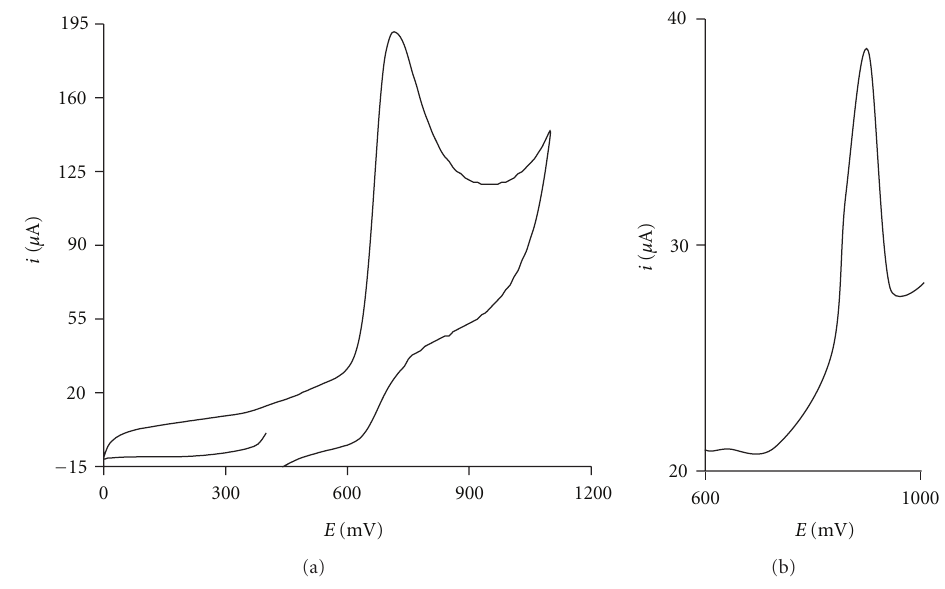
Figure 6: (a) Cyclic voltammogram of AAP at pH 1.0 on RF/GCE; scan rate 100mVs − 1 (b) SWSV of AAP on RF/GCE under optimum